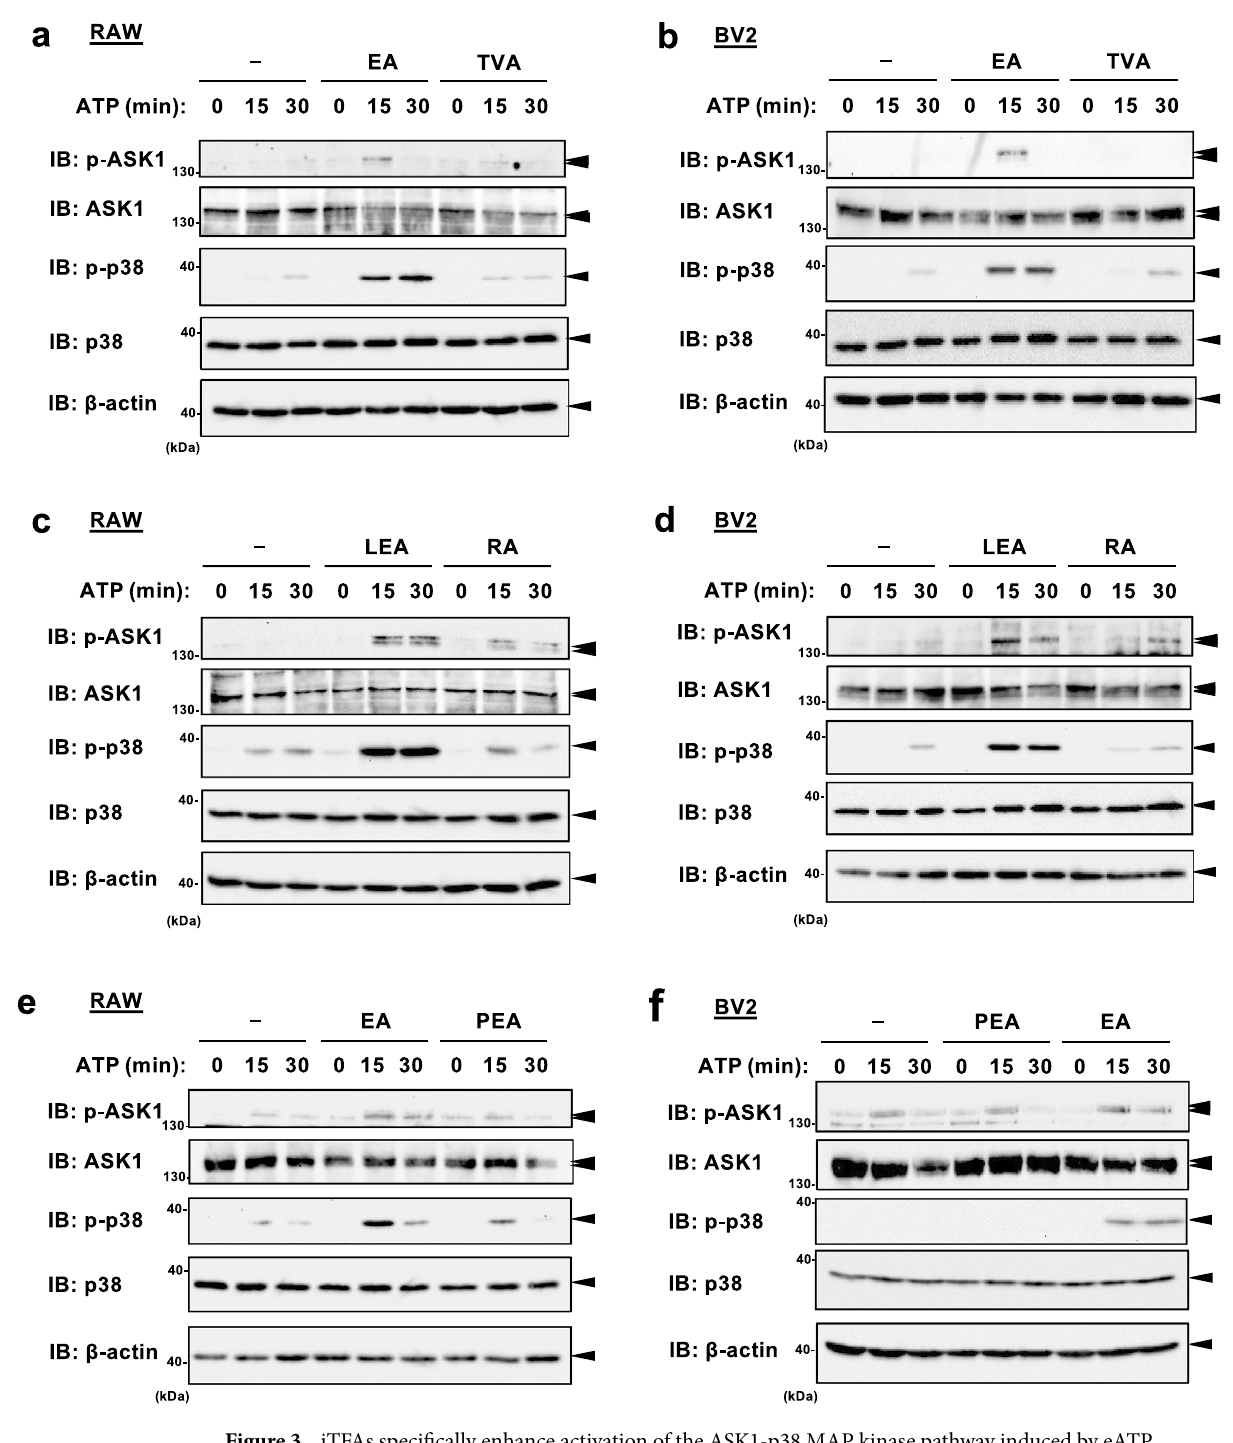
Figure 3. iTFAs specifically enhance activation of the ASK1-p38 MAP kinase pathway induced by eATP. ( a – f ) RAW264.7 ( a – c ) and BV2 ( d – f ) cells were pretreated with the indicated TFAs for 12 h at 200 µM, treated with ATP at 0.5 mM for 0, 15 or 30 min, and then subjected to immunoblotting with the indicated antibodies. Quantifications of immunoblots are shown in Supplementary Fig. S5. Original blots are presented in Supplementary Fig.